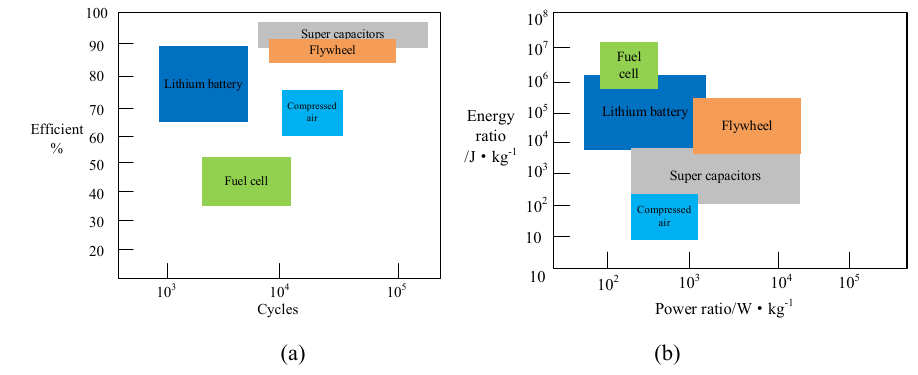
Fig. 1. The comparison of typical energy storage